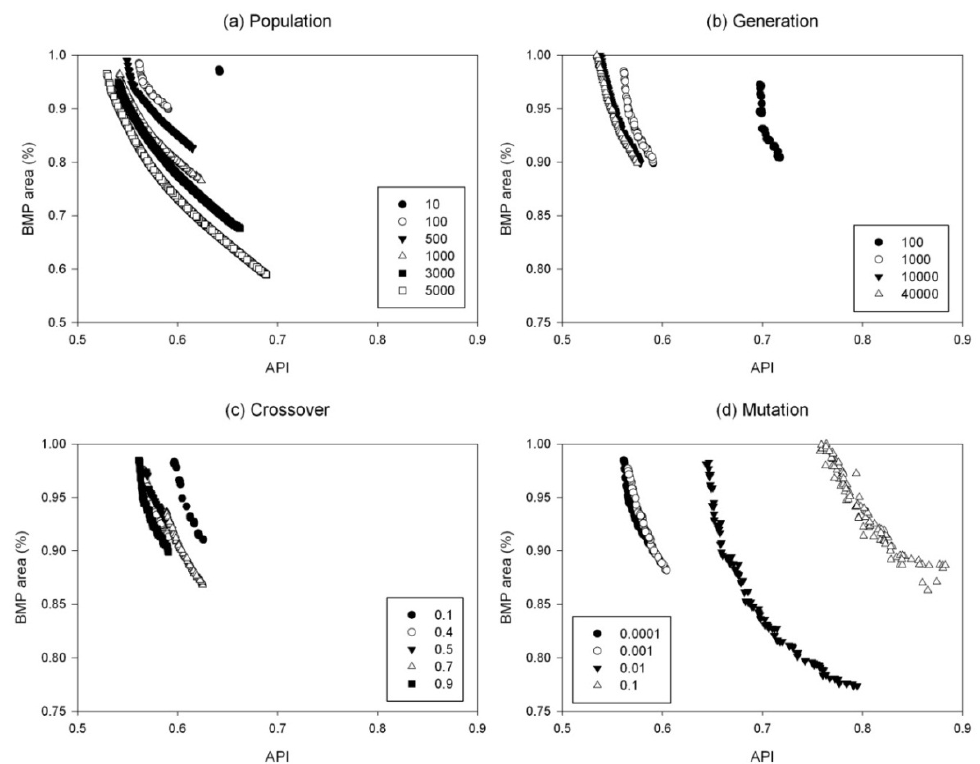
Figure 3. Pareto-optimal fronts for the sensitivity analysis of genetic algorithm (GA) parameters for the optimization model with a set of 171 BMP options